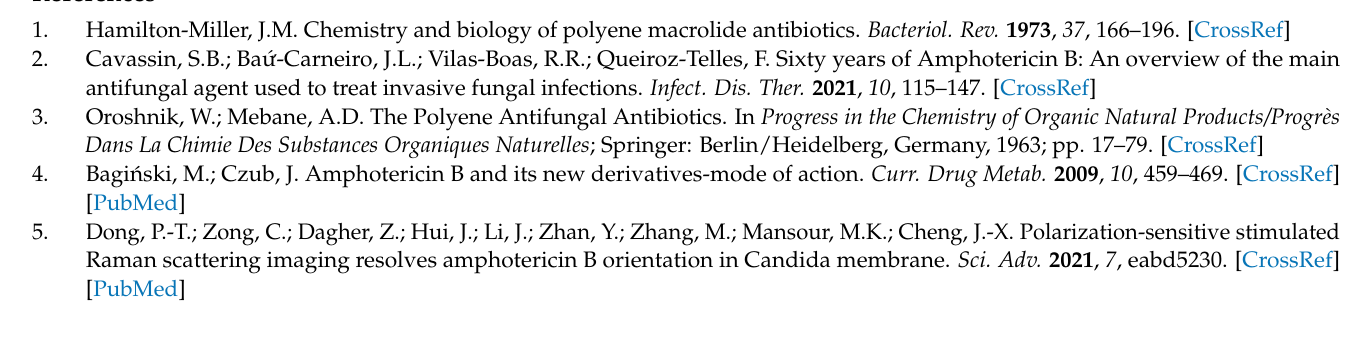
isomers.; Figure S3A–F: Fragments of 2D DOF-COSY 1H NMR spectra of CndD, ParA, ParB and their all-trans isomers.; Figure S4: Structures of the AH/sterol